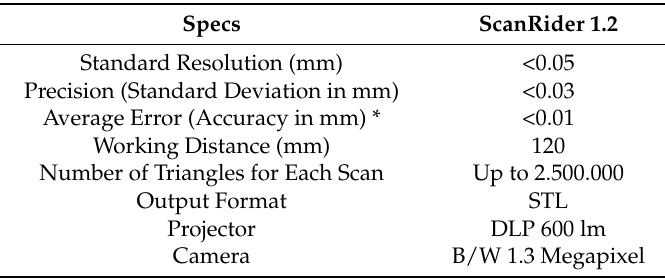
Table 1. Technical specifications and performance parameters.